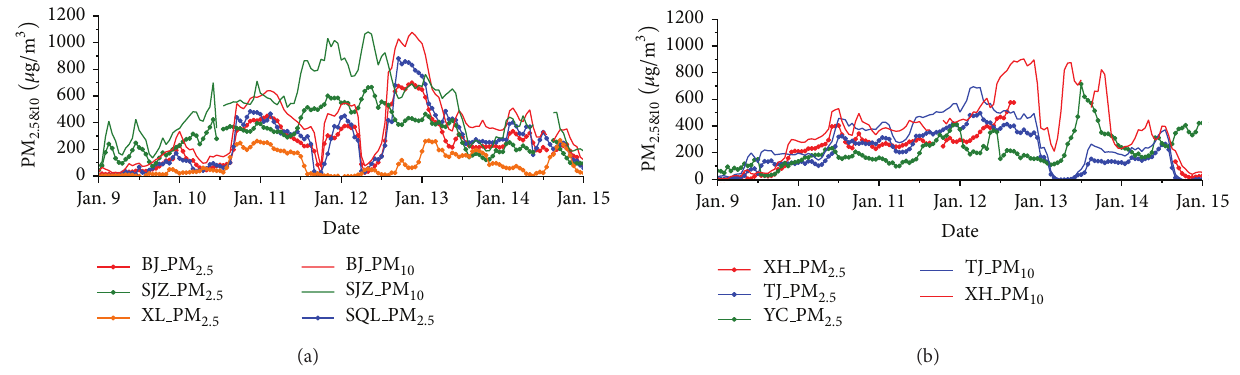
Figure 9: Variation of hourly average concentrations of PM 2.5 and PM 10 for different sites in the BTH region from January 9 to 14.